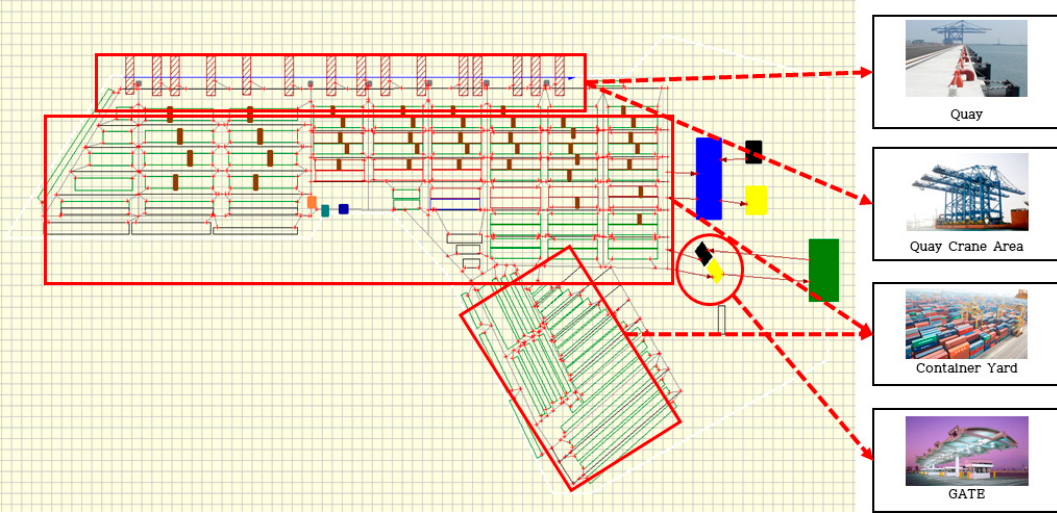
Figure 4. Virtualized port-container terminal.